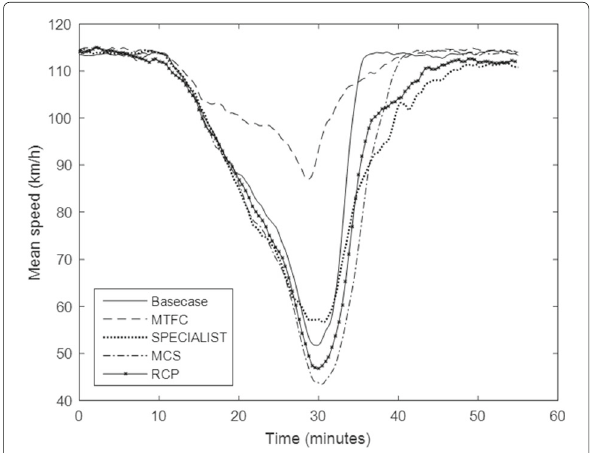
Fig. 3 Mean speed over the whole stretch for the base case and the VSL